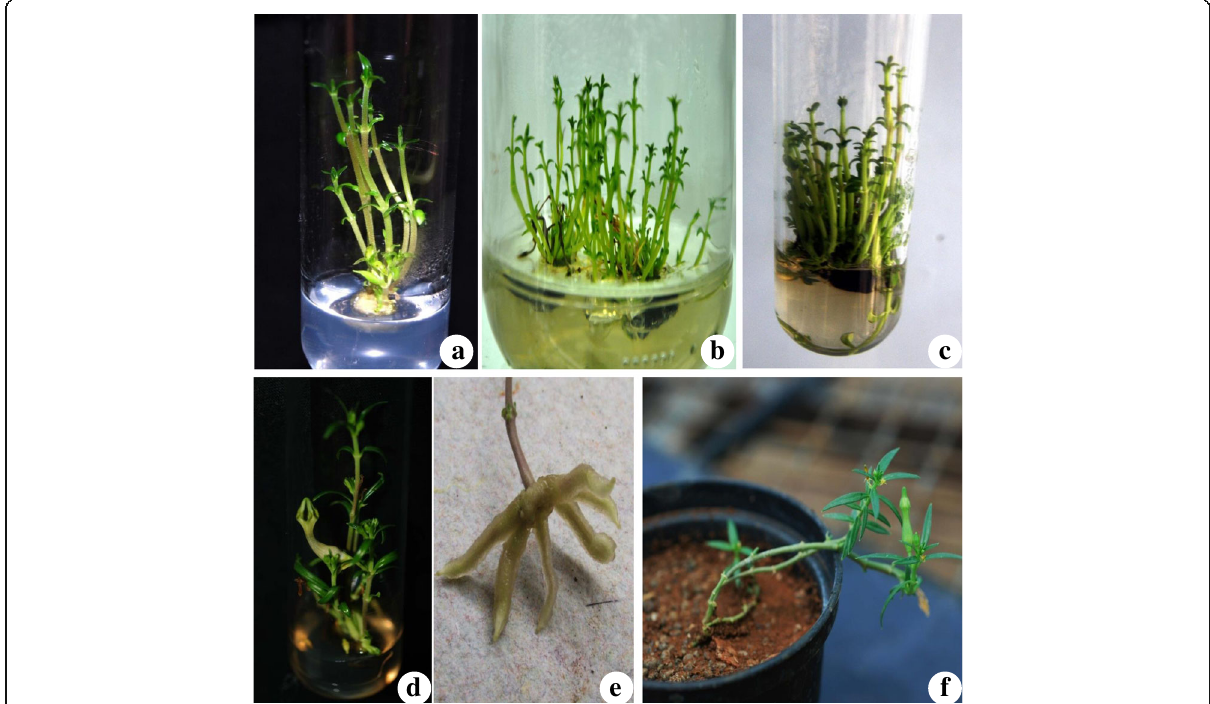
Fig. 1 Micropropagation of C. mohanramii . a Shoot initiation (MS + BAP 1.0 mg/l). b , c Shoot multiplication (MS + BAP 2.0 + IBA 0.5 mg/l). d In vitro flowering (MS + BAP 2.0 + IAA 1.5 mg/l). e In vitro rooting (½ MS + IBA 1.5 mg/l). f Hardened plant